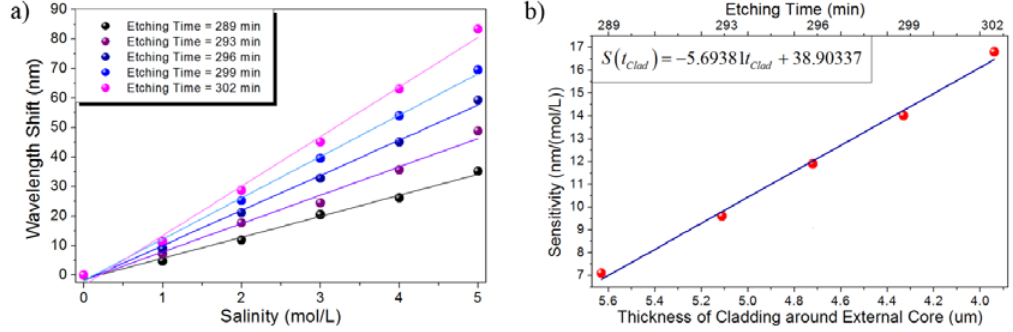
Figure 8. Salinity, high-concentration regime: ( a ) Absolute wavelength shift of the sensor response; ( b ) Sensitivity of the TCF sensor as a function of the remaining